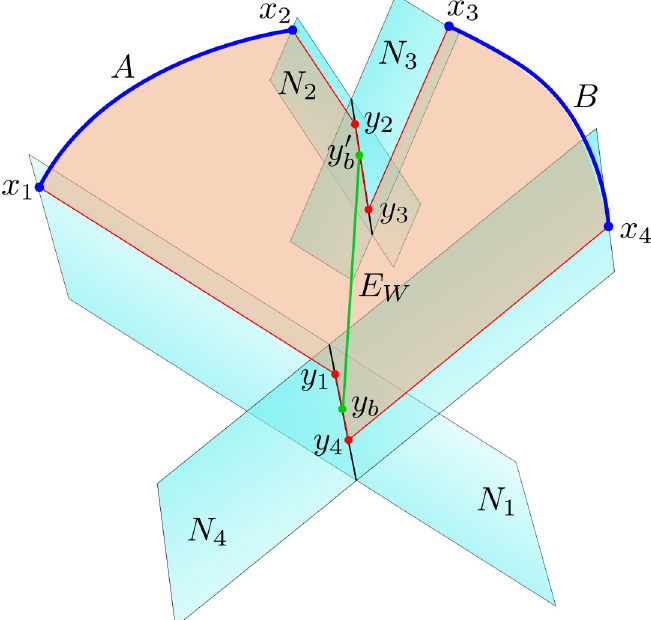
Figure 4: Schematics for the holographic construction of the EWCS for two disjoint intervals in a GCF T dual to Einstein gravity in asymptotically flat spacetime. The 1 + 1 shaded region bounded by the red line segments describing the extremal curves Γ extr and the boundary intervals A and B , is the entanglement wedge dual to ρ